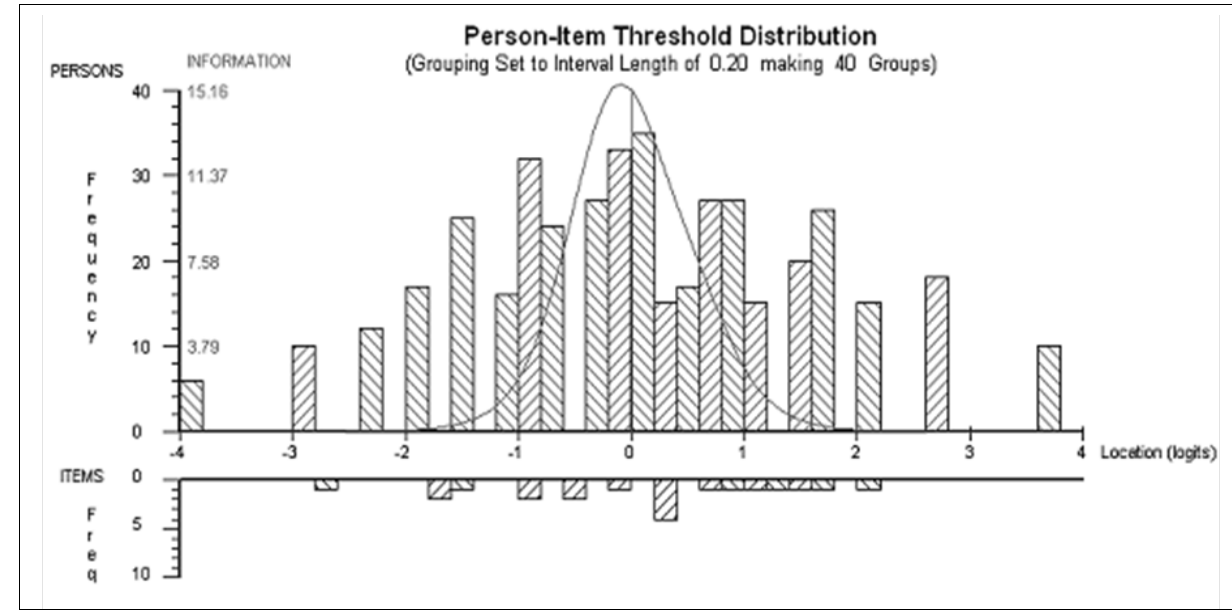
FIGURE 4 Person-item threshold distribution and information function for the Mobility Preference